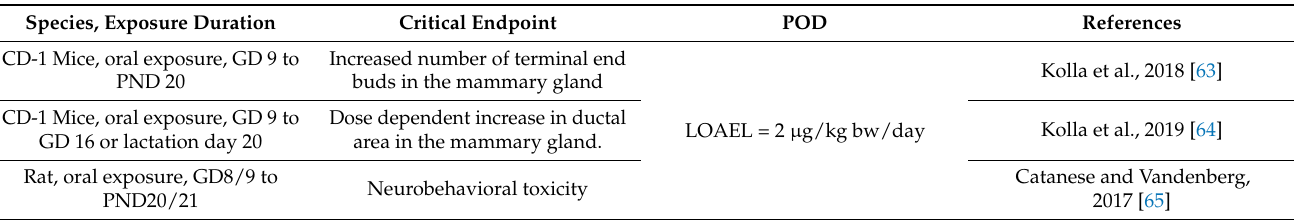
Table 3. Key studies and selection of the POD for the derivation of the